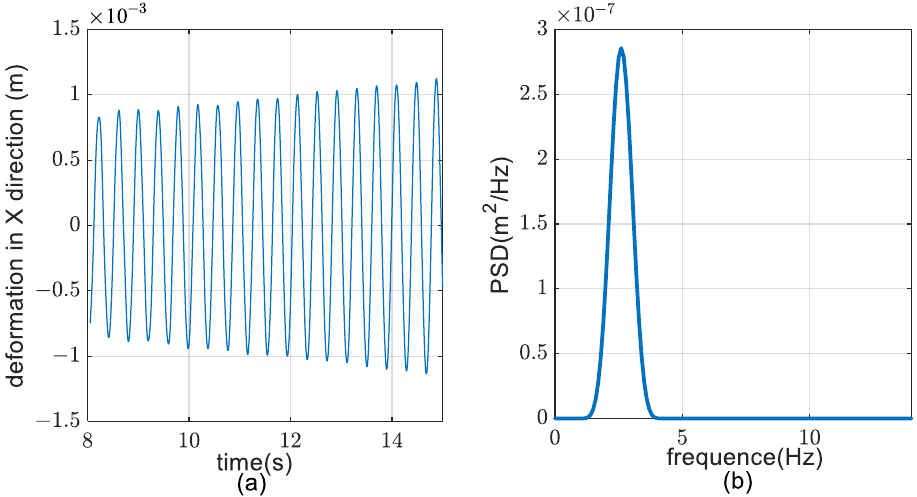
Figure 14. Spectral analysis of the X displacement of the monitoring point. ( a ) Deformation in the X direction. ( b ) PSD of deformation in the X direction.